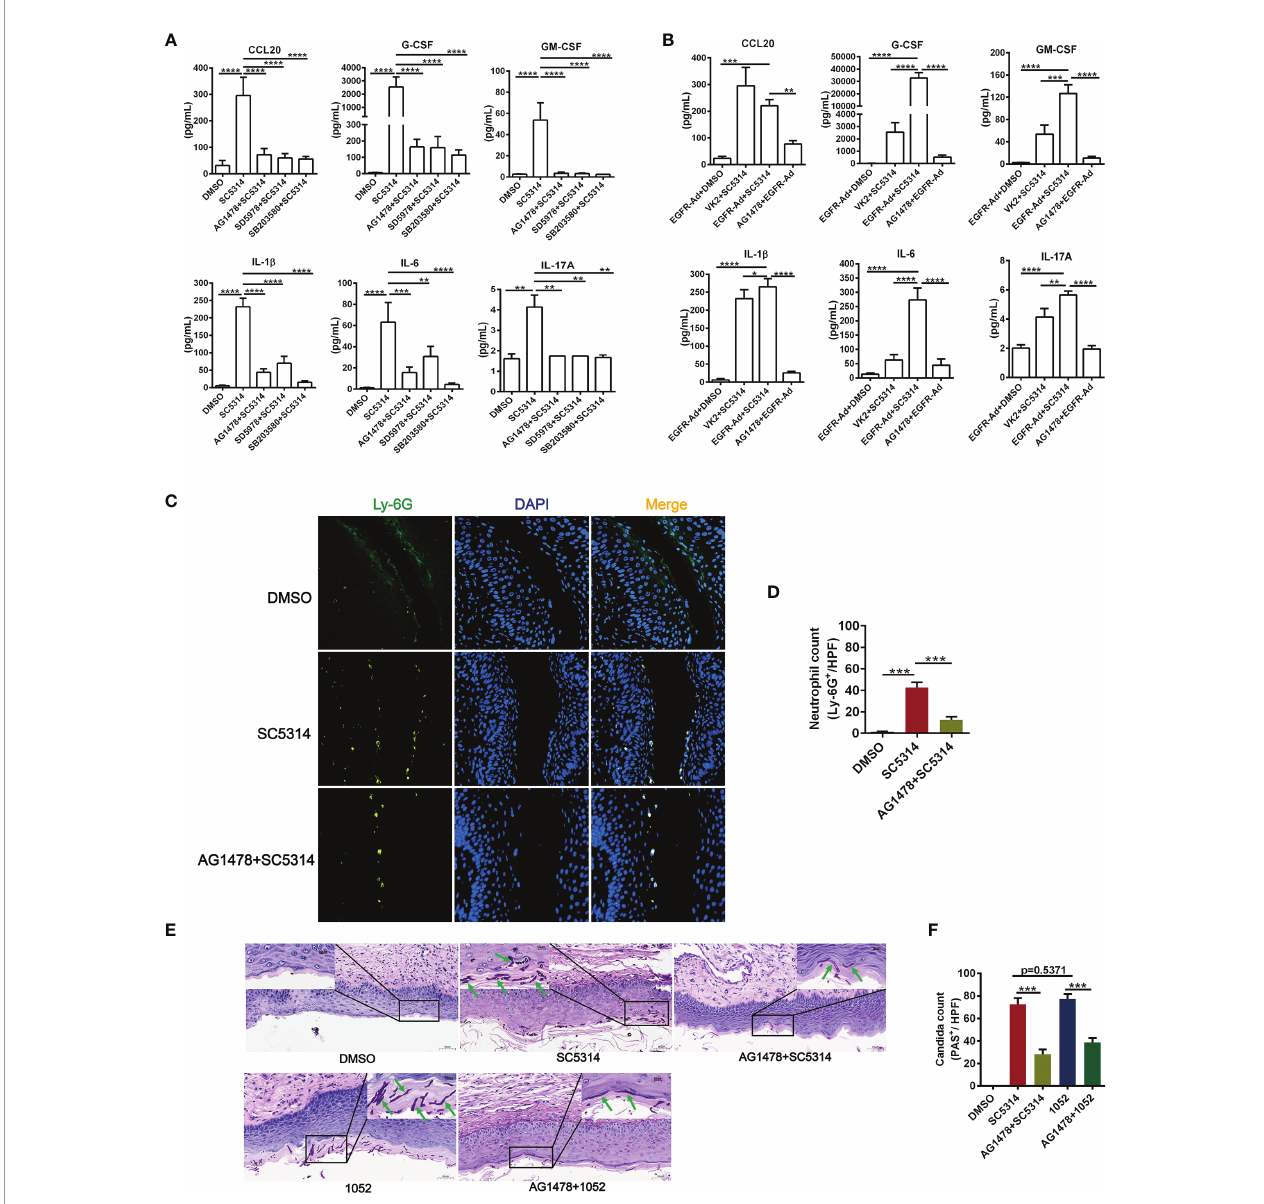
FIGURE 2 | Functionalroleof EGFR andMAPKsignalinginregulating vaginalepithelial in fl ammatory responses. Quanti fi cation ofcytokines were assessed bymultiplex microbeadassay (luminex),secretedfromVK2/E6E7 vaginal epithelial cells stimulatingwith SC5314(MOI=0.01) for 24 h.EGFRinhibitorAG1478, p38 inhibitor SB203580 or ERK1/2inhibitorSD5978 was added to the cells 2 h prior to fungal stimulation. Alltheseinhibitorssuppressed SC5314-inducedsecretion of cytokines (CCL20, G-CSF, GM- CSF, IL-1 b , IL-6, IL-17A) (A) . EGFR-Ad-VK2 released higher levelsof cytokines (G-CSF, GM-CSF,IL-1 b , IL-6, IL-17A) inducedby SC5314 when comparedto VK2/E6E7 cells, which can besuppressed byAG1478 (B) . VVC micewere treated as previously ( Figure 1D ).Vaginal sectionsfrom C. albicans – infected mice were assayed for immuno fl uorescence staining of Ly-6G (neutrophilmarker,green)and nuclei were counterstained with DAPI (blue) (C) . Numbersingraph (D) providethe mean neutrophils count per group (n=3/each group).Fungal loadin vaginal tissues was assessedby periodic acid-Schiff (PAS). Insets show regionsof vaginal fungal burden andhigher- magni fi cation images of the organismsindicated bythe arrows (E) . Numbersingraph (F) providethe mean C. albicans count per group (n=3/each group).Data are representative of three independent experiments. Error bars represent SD, *p < 0.05, **p < 0.01, ***p < 0.001, ****p <